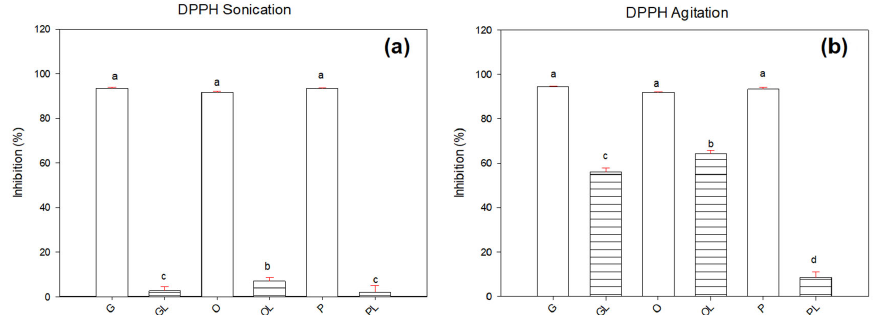
Figure 5. DPPH radical inhibition in samples subjected to ( a ) sonication and ( b ) agita ‐ tion. Letters (a–c) represent significant differences between samples. (a–d) represent significant differences between